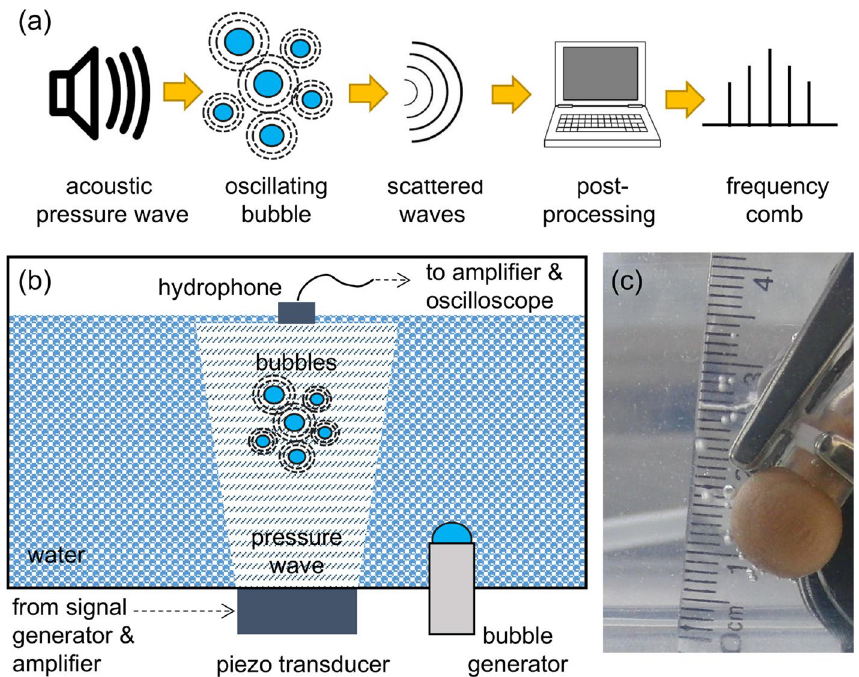
Figure 1. (a) Schematic diagram of the suggested AFC generation. The oscillations of the bubble cluster are driven by a single-frequency ultrasound pressure wave. Acoustic waves scattered by the bubble cluster are recorded and post-processed to obtain a spectrum consisting of the equidistant peaks. (b) Schematic of the experimental setup. Bubbles are created in a stainless steel tank using a bubble generator. The driving